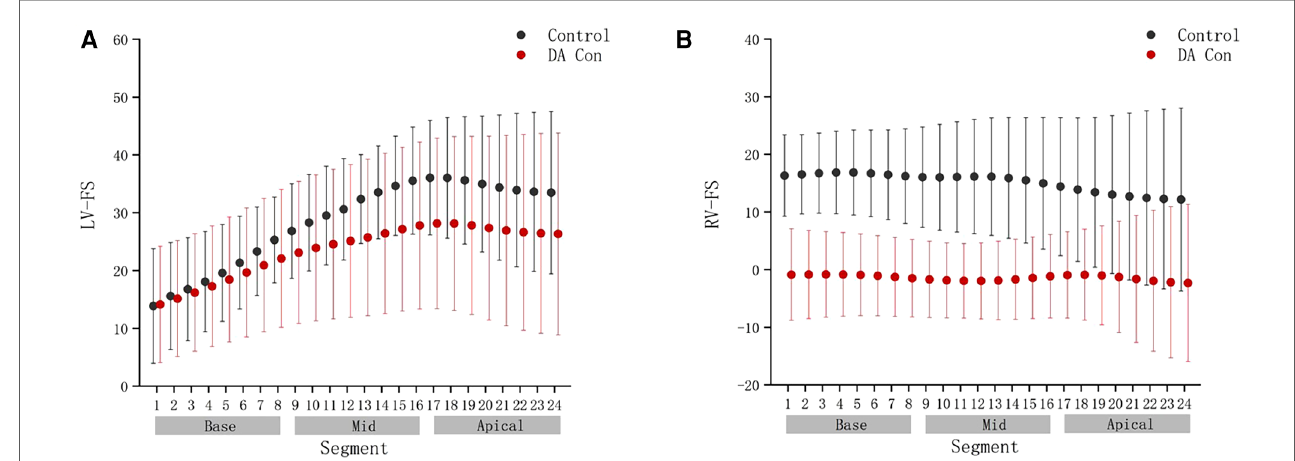
FIGURE 7 Comparison of ventricular 24-segment fractional shortening (FS) from the base to the apex between the control group and ductus arteriosus constriction (DA Con) group. ( A ) Left ventricle (LV) 24-segment FS values in the control group and DA Con group. ( B ) Right ventricle (RV) 24-segment FS values in the control group and DA Con group.